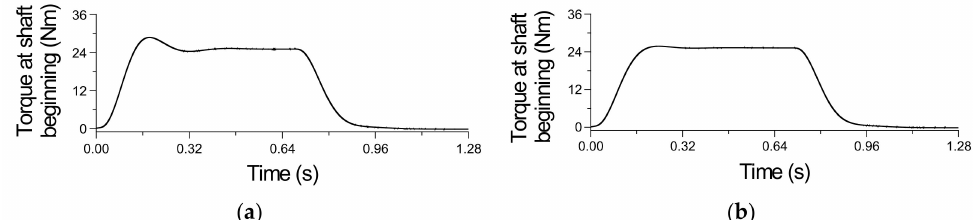
Figure 12. Waveforms of the torque at the beginning of the transmission shaft in the control system shown in Figure 7 with a linear ( a ) and non-linear ( b ) torque limit controller during motor start-up.